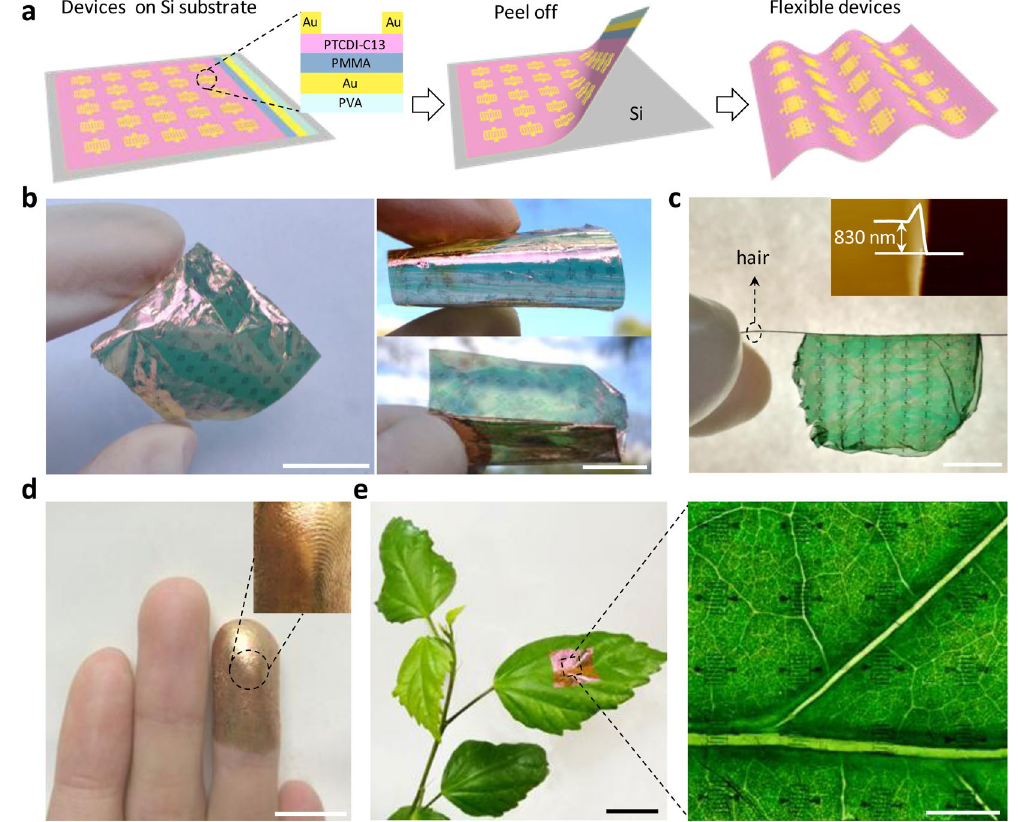
Figure 1. Ultra-flexible and conformable organic phototransistor array based on PTCDI-C 13 H 27 thin film. ( a ) Schematic images showing the flexible compatible device array peeled from Si substrate. The inset shows the cross-sectional schematic illustration of a single device. ( b ) Photograph of 10 × 11 device array with the area size of 3 × 3 cm 2 adhered onto a 10- µ m commercialized plastic wrap. ( c ) Photograph of device array sustained by a hair. AFM in the inset indicates the thickness of the device array at only ~830 nm. ( d ) Photograph of the device adhered on loops and whorls on human finger. ( e ) Photograph of the device adhered to a plant leave. The right image shows the detailed devices on the plant leave. Scale bar: 1